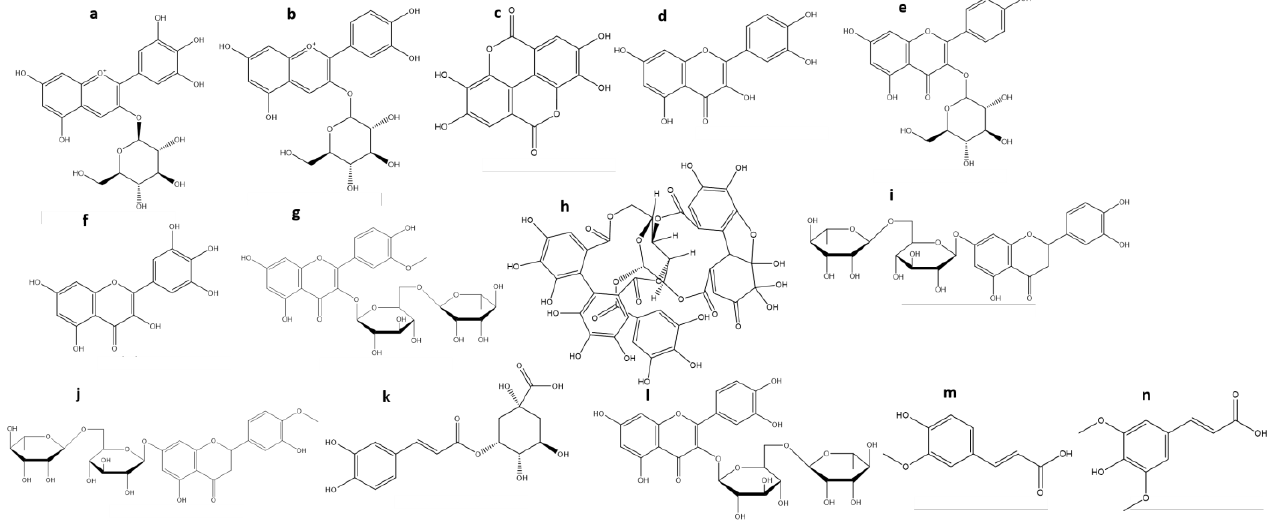
Figure 3. The chemical structure of the main chemical compounds present in the fruits of Maqui. Chemical structures corresponding to a , Delphinidin-3-glucoside; b , Cyanidin-3-glucoside; c , Ellagic acid; d , Quercetin; e , Kaempferol-3-glucoside; f , Myricetin; g , Isorhamnetin-3 -rutinoside; h , Gra- natin B; i , Eriodic-tyol-7-rutinoside; j , Hesperetin-7-rutinoside; k , 5- O -caffeoylquinic acid; l , Rutin; m , Ferulic acid and n , Sinapic